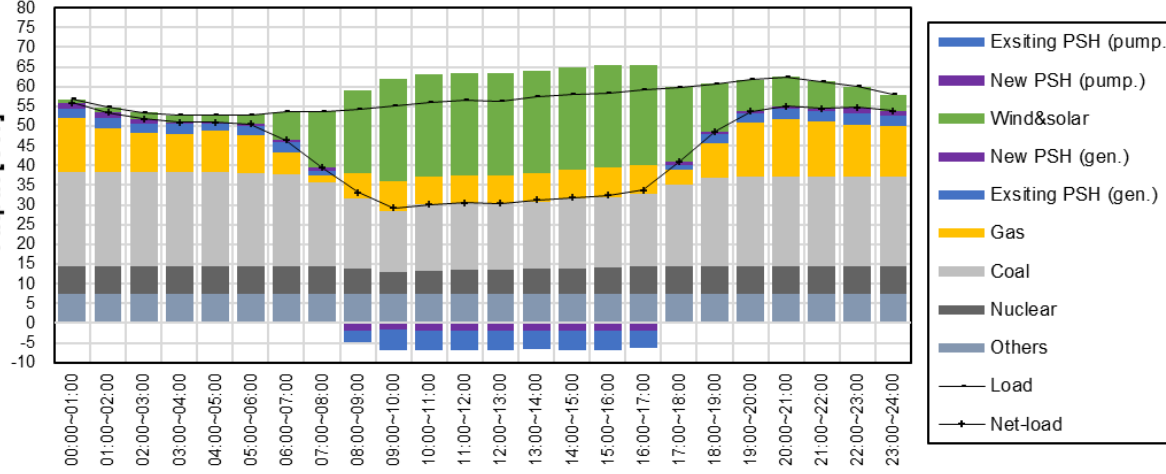
Figure 13. The UC solution diagram of Scenario C.